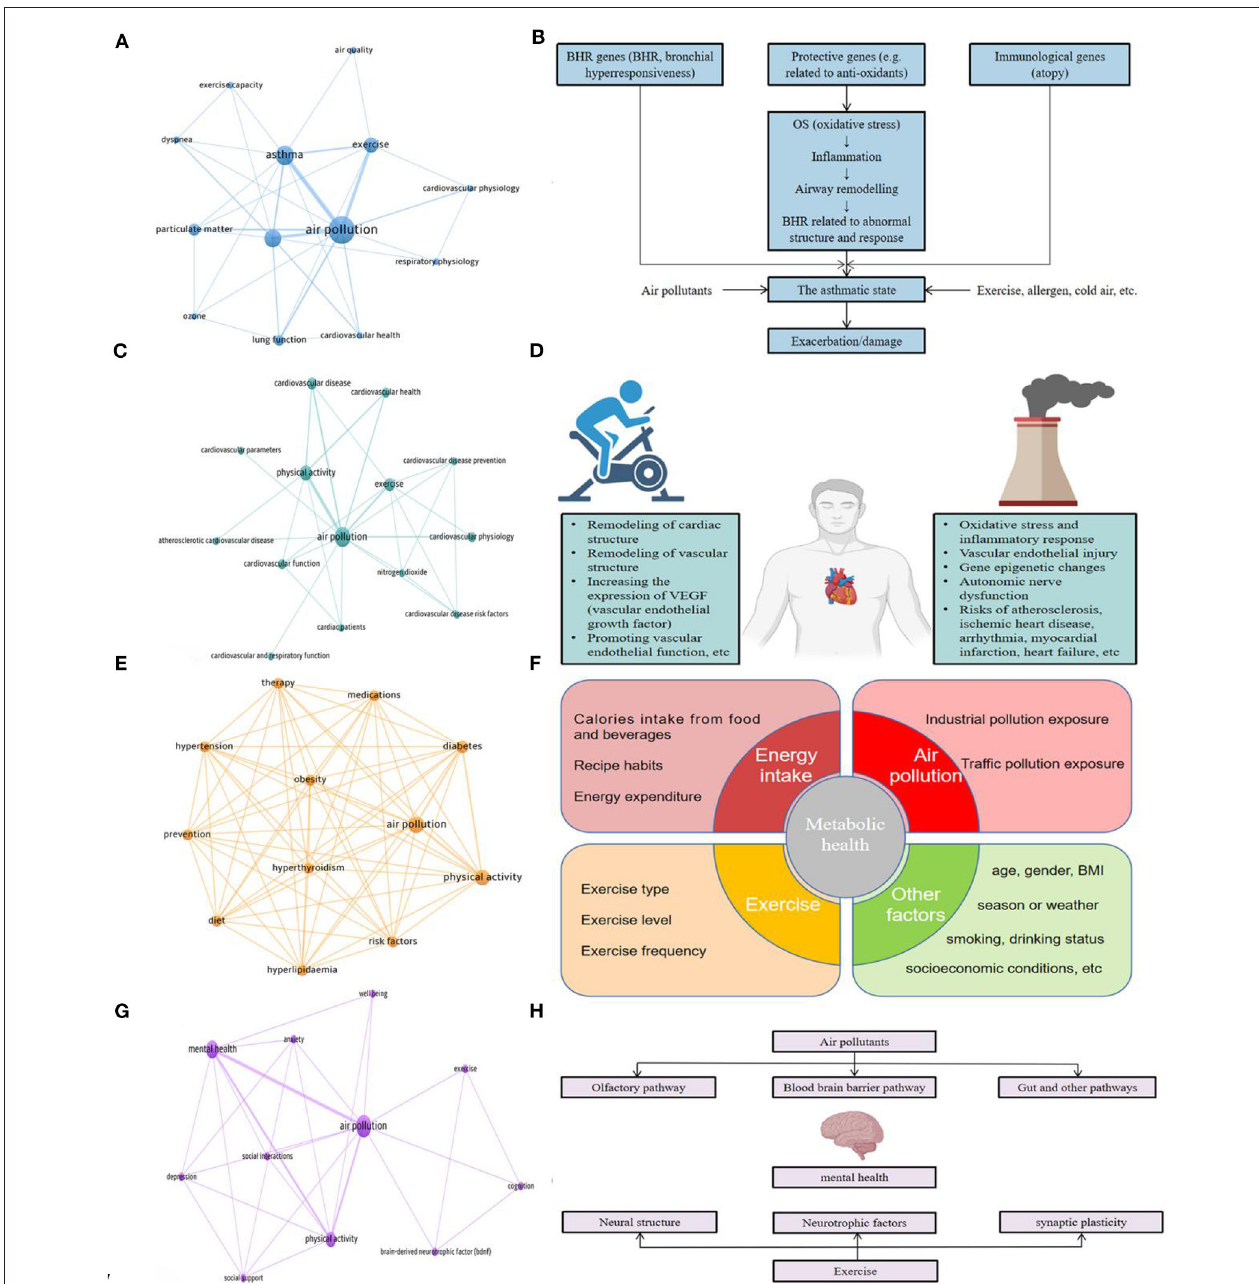
FIGURE 7 | (A) Network connections among keywords in respiratory health-related research in the AP-PE field; (B) the mechanistic process for air pollutants leading to asthma (B) was adapted from reference Gowers et al. (2012); (C) network connections among keywords in cardiovascular health-related research in the AP-PE field; (D) mechanisms and relationships between exercise and air pollutants to the cardiovascular system; (E) network connections among keywords in metabolic health-related research in the AP-PE field; (F) major factors affecting metabolic health; (G) network connections among keywords in mental health-related research in the AP-PE field; (H) pathways and factors of air pollutants and exercise on mental health.